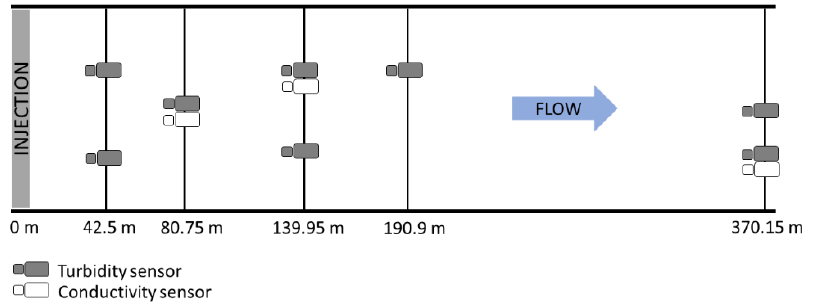
Figure 4. Instrument deployment configurations used in multiple experiments in the concrete channel.